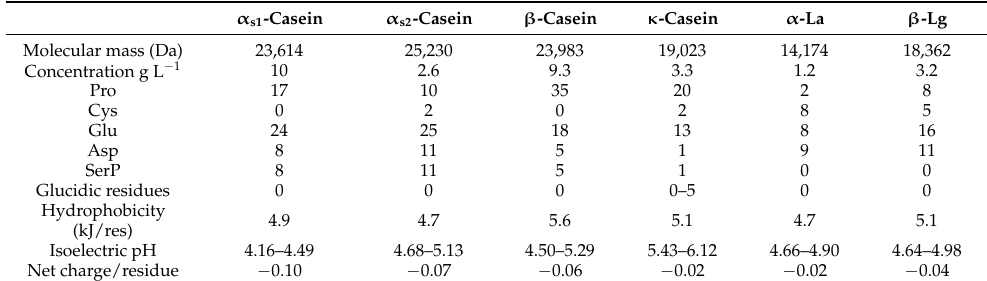
Abbreviations: Pro (proline), Cys (cysteine), Glu (glutamic acid), Asp (aspartic acid), SerP